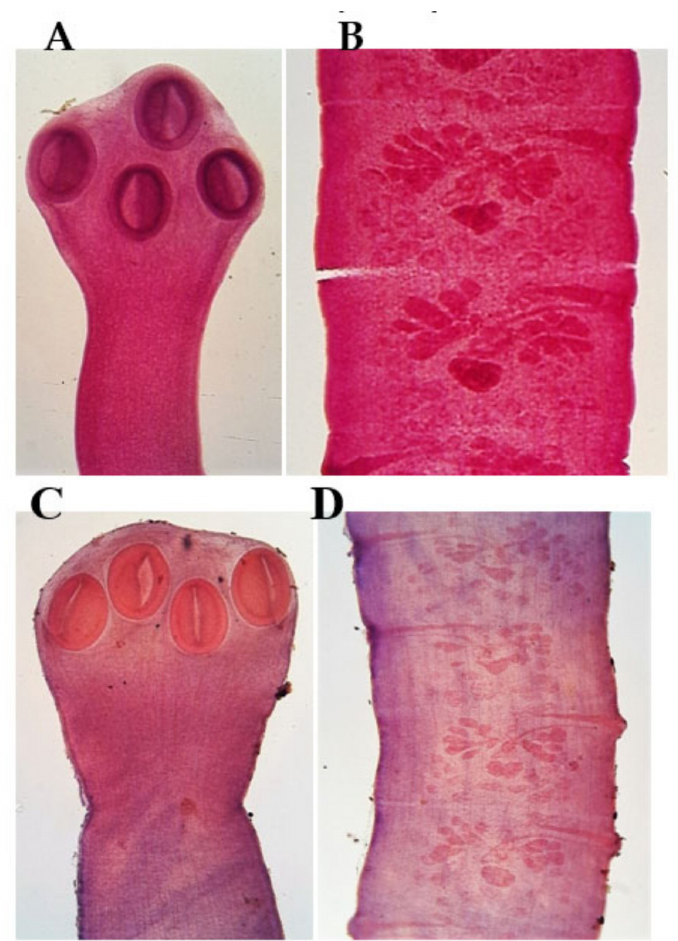
Figure 4. ( A – D ) Oochoristica sp. infecting anurans: ( A , B ) scolex and mature proglottid of parasite infecting Sclerophrys maculata ; ( C , D ) scolex and mature proglottid infecting Ptychadena oxyrhynchus